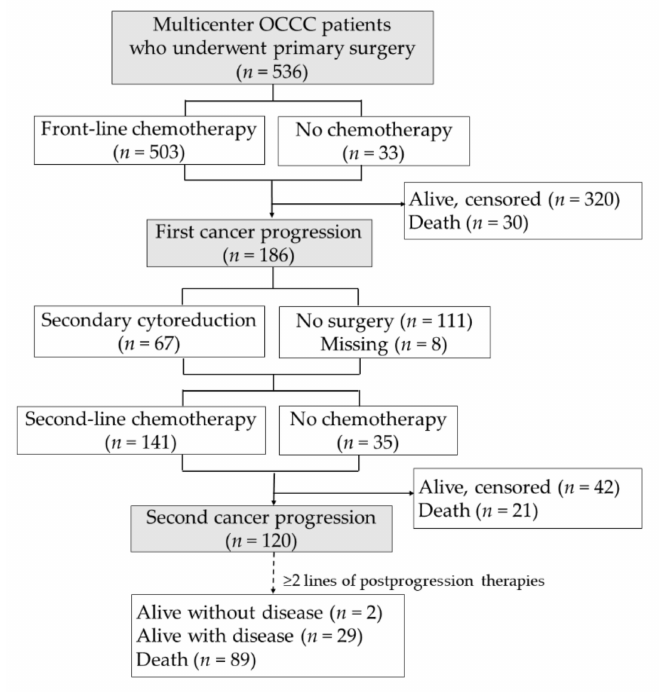
Figure 1. Treatment algorithm of the enrolled patients after undergoing primary treatments ( n =